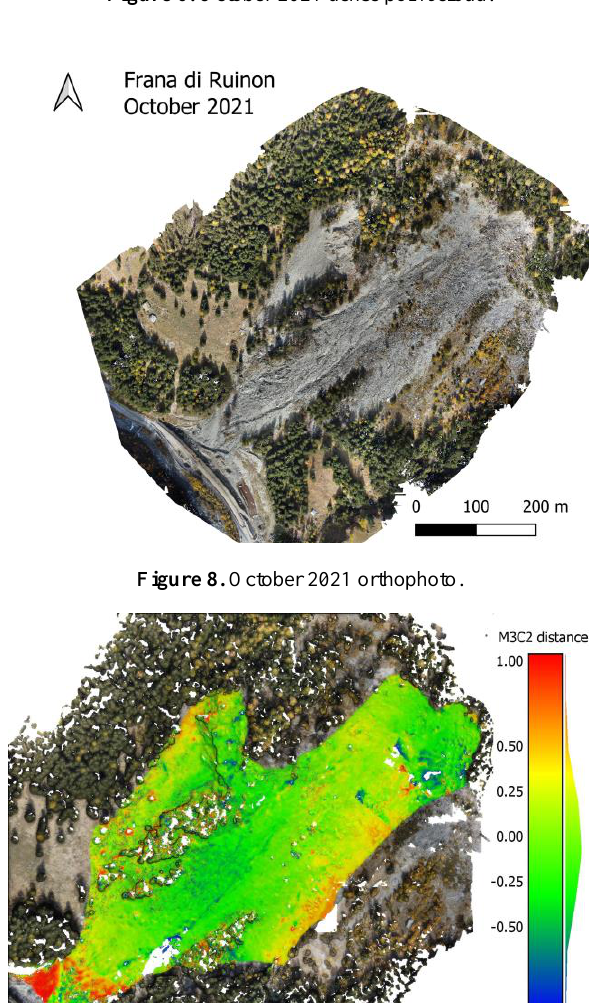
Figure 5. July 2021 dense point cloud. Figure 6. October 2021 dense point cloud.